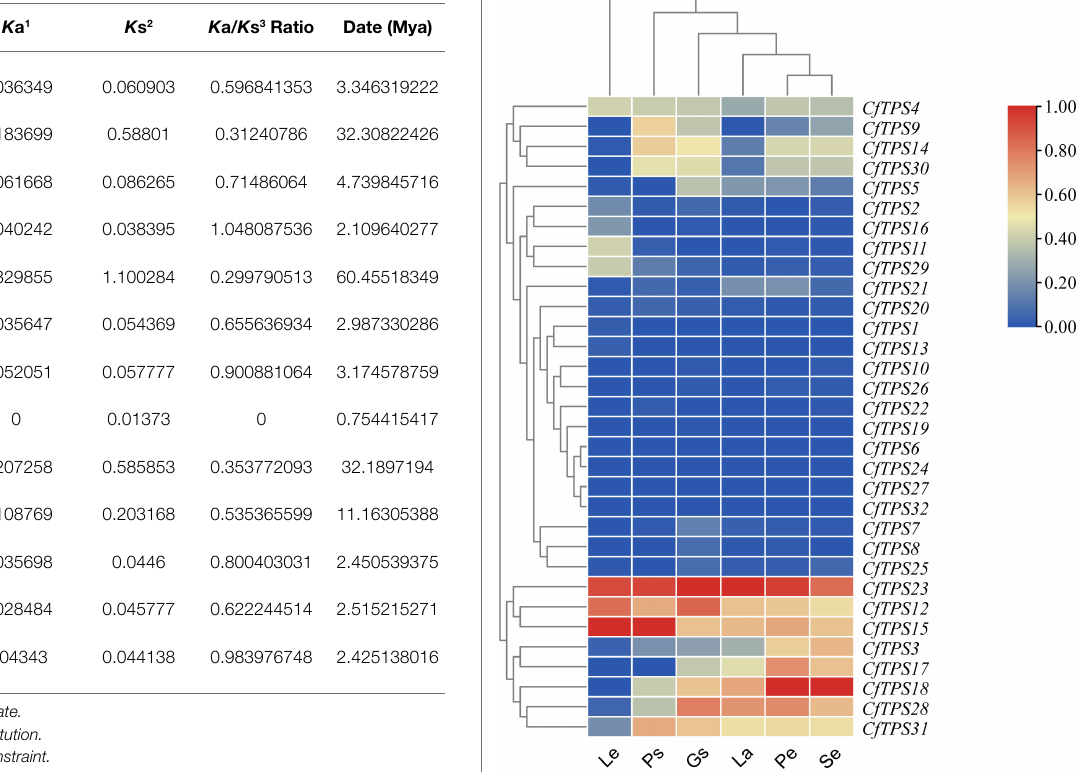
TABLE 2 | K a/ K s analysis of TPS genes in C. faberi .